Question: What form of chart is displayed?
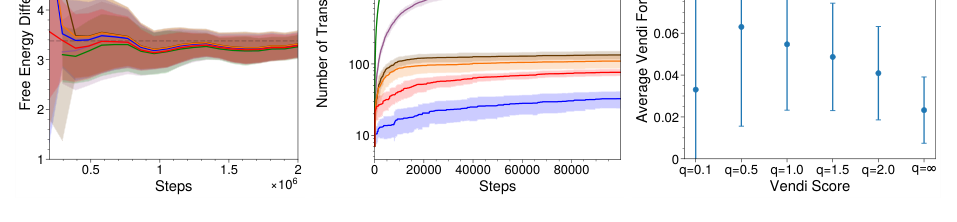
Answer: line